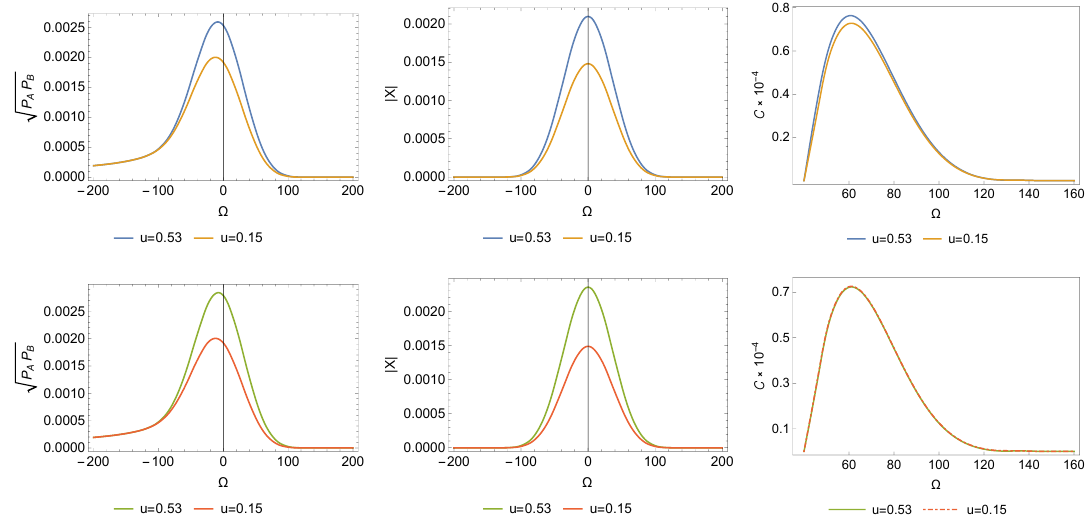
Figure 6 . Insensitivity of detector excitation spectrum to the sign of the energy density. While the local energy density for (cid:24) = 0 : 99 mirror can be negative, that of the (cid:24) = 1 mirror is always positive (see (cid:12)gure 4). It is known that the transition rate of detectors exhibit a thermal spectrum at the temperature corresponding to that of the surrounding thermal radiation in the case of black hole radiation and Unruh e(cid:11)ect. Though we are unable to directly compute the spectrum of the detectors due to the numeric nature of this work, we can nonetheless plot both P j and j X j against (cid:10) numerically to see how both depend on the sign of the energy density. The two curves on each of these plots are obtained by respectively placing detector A at u = 0 : 15 ; 0 : 53, which experiences a positive and negative energy density (for the (cid:24) = 0 : 99 mirror). The detector settings p are (cid:1) (cid:28) = 0 : 136 ; (cid:1) x = 0 : 05 ; (cid:10) = 50 ; (cid:20) = 48 (cid:25); x A = 0. The results for (cid:24) = 0 : 99 ( top ) mirror shows p that regardless of the sign of the energy density, the noise ( P A P B ), correlation and concurrence plots assume similar shapes. The di(cid:11)erences in the heights of the curves are not a result of the di(cid:11)erence in sign of the energy density, since the same is also observed for the (cid:24) = 1 ( bottom ) mirror (energy density positive